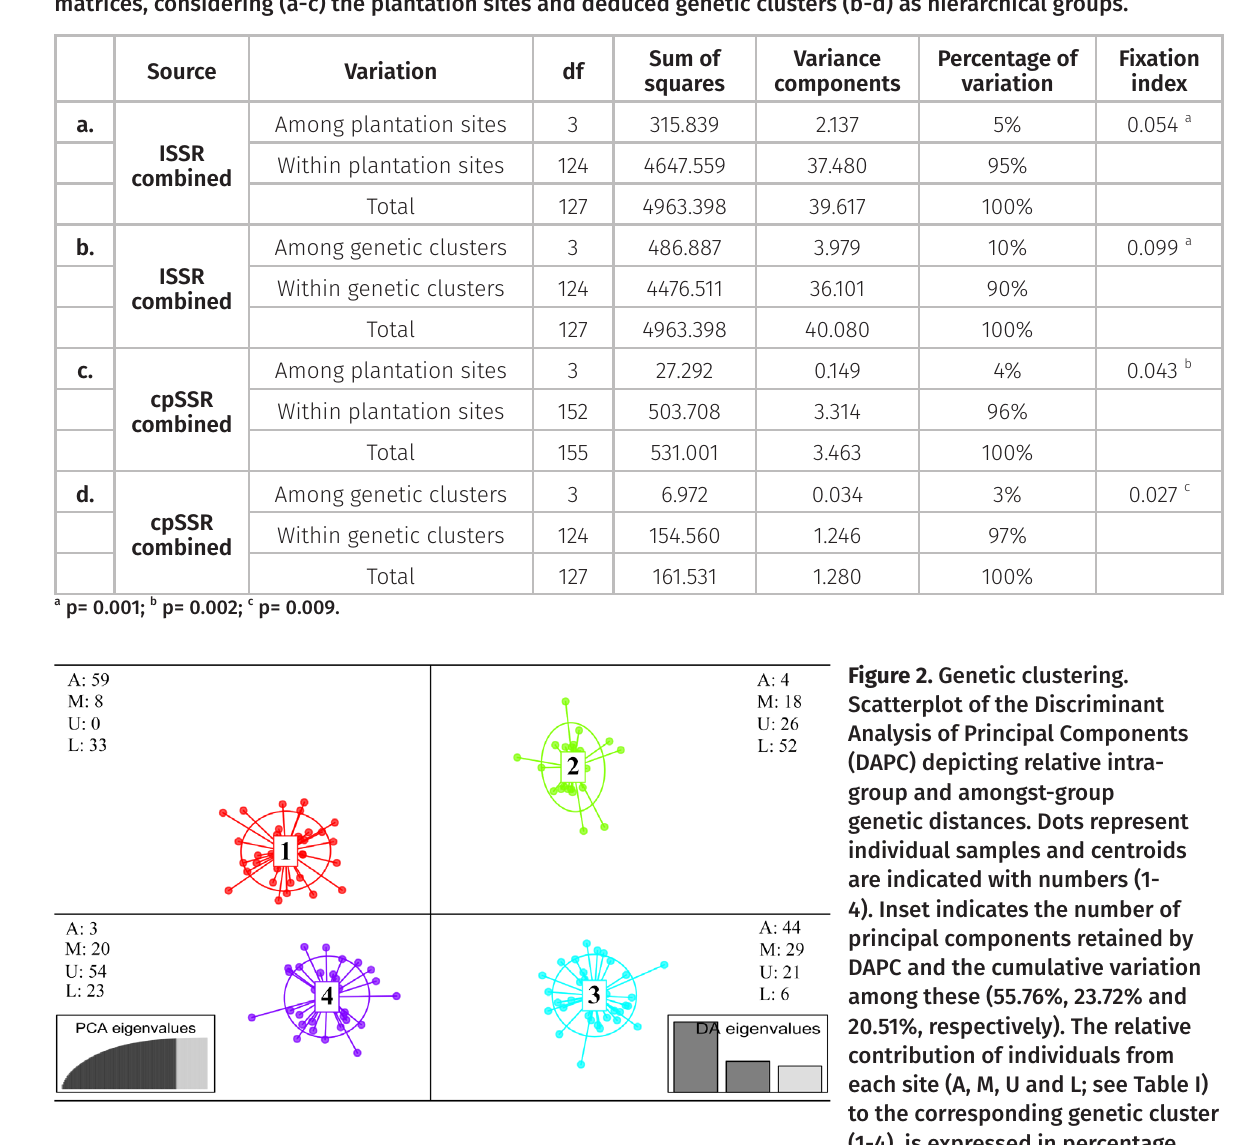
Table IV. Results from analyses of molecular variance (AMOVA) performed on combined ISSR (a-b) and cpSSR (c-d)